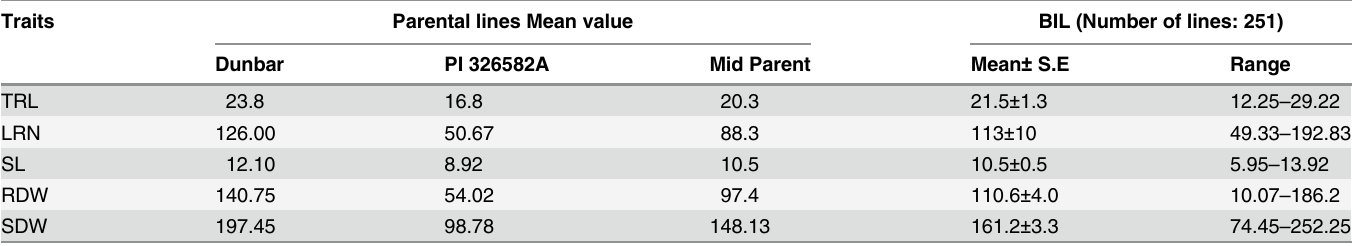
Table 2. Statistical analyses of seedling root and shoot traits in the BIL population and the parents (n = 6) with a signi fi cant P value < .0001. Traits